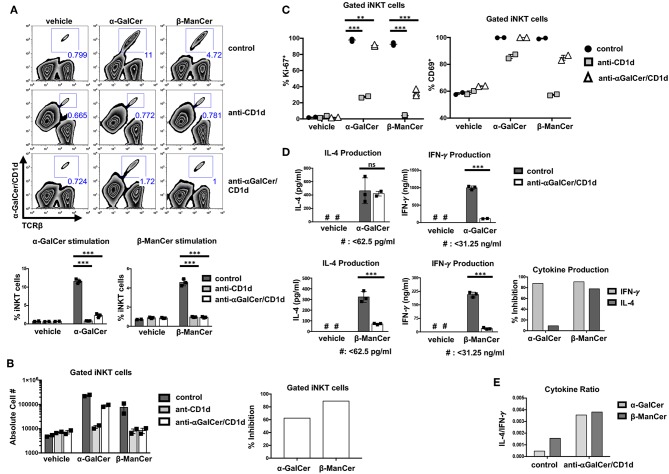
Antibodies specific for CD1d-α-GalCer inhibit glycolipid-induced activation of bulk splenic iNKT cells. (A) Mouse splenocytes were stimulated with vehicle, α-GalCer (100 nM) or β-ManCer (1 μM), for 3 days in the presence of anti-CD1d (10 μg/ml) or anti-CD1d-α-GalCer (10 μg/ml for vehicle and β-ManCer; 100 μg/ml for α-GalCer condition) or in the absence of antibodies (control). Proportions of iNKT cells in the culture were enumerated with flow cytometry by using α-TCRβ (or α-CD3) and PBS57/CD1d tetramer. (B) The absolute number of iNKT cells was determined by using CountBright Absolute Counting Beads. Percent inhibition of iNKT cell proliferation induced by blocking antibodies was calculated as described in section Methods. (C) Mouse splenocytes were stimulated with vehicle, α-GalCer (100 nM), or β-ManCer (1 μM) for 3 days in the presence of anti-CD1d (10 μg/ml) or anti-CD1d-α-GalCer (10 μg/ml for vehicle and β-ManCer conditions; 100 μg/ml for α-GalCer condition) or in the absence of antibodies (control). iNKT cells, gated as in A, were examined for expression of intranuclear Ki-67 or expression of surface CD69. (D) Mouse splenocytes were stimulated with vehicle, α-GalCer (100 nM), or β-ManCer (1 μM) for 4 days in the presence of anti-CD1d (10 μg/ml) or anti-CD1d-α-GalCer (10 μg/ml for vehicle and β-ManCer conditions; 100 μg/ml for α-GalCer condition) or in the absence of antibodies (control). Concentrations of IFN-γ and IL-4 in the supernatant were determined by ELISA. Percent inhibition of cytokine production induced by blocking antibodies was calculated as described in section Methods. Data are plotted as mean with range of duplicates (B,C) or as mean ± SD of triplicates (A,D). Three replicates per experimental group were combined to calculate % inhibition and cytokine ratio (B,D,E). Representative experiments of 3 independent repeats are shown (A–E). ***p < 0.0001; **p < 0.0040; ns: not significant.